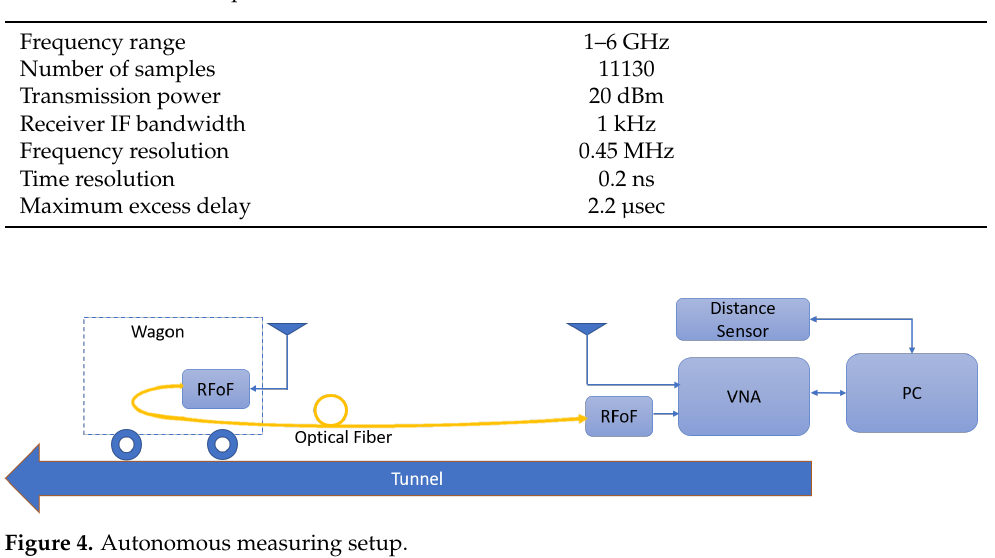
Table 6. Measurement parameters.